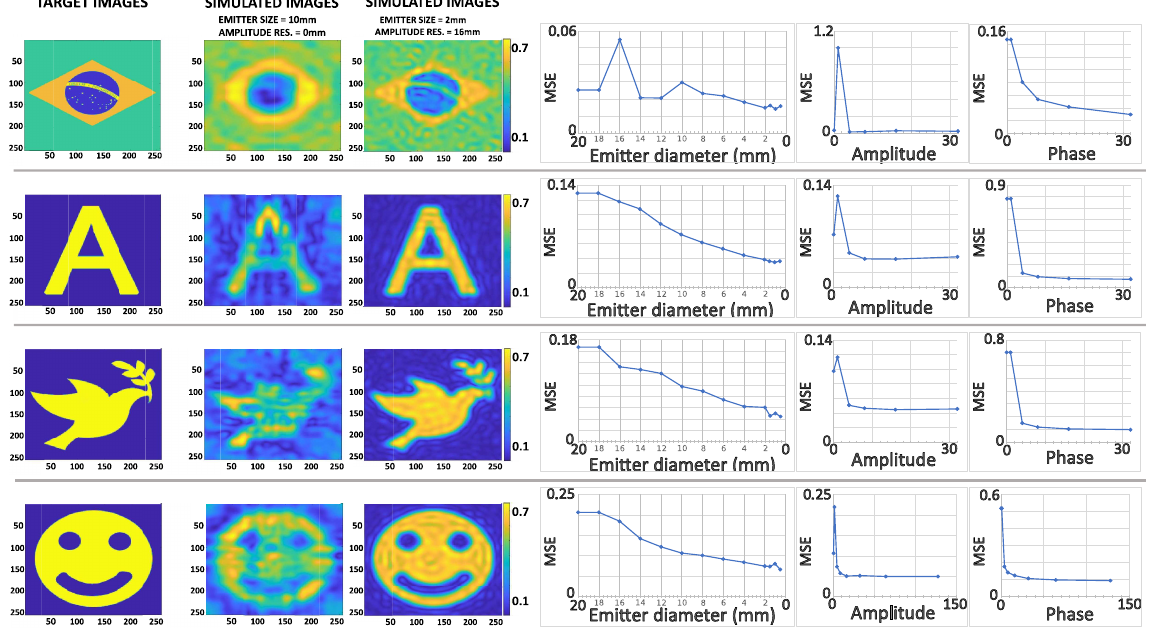
Figure 9. Simulated amplitude fields at 16 cm from the array for different target patterns and array parameters. (First column) target amplitude field. (Second column) obtained amplitude field when the emitter array is the surface mounted device (SMD) board presented in the paper, i.e., emitterSize = 10 mm (transducer diameter), phaseResolution = 32 and no amplitude modulation. (Third column) obtained amplitude fields with an array with emitterSize = 2 mm, phaseResolution = 32 and amplitudeResolution = 16. (Fourth column) mean square error (MSE) as the emitter size decreases. (Fifth column) MSE as phase resolution increases, emitterSize = 10 mm. (Sixth column) MSE as the amplitude resolution increases, emitterSize = 10